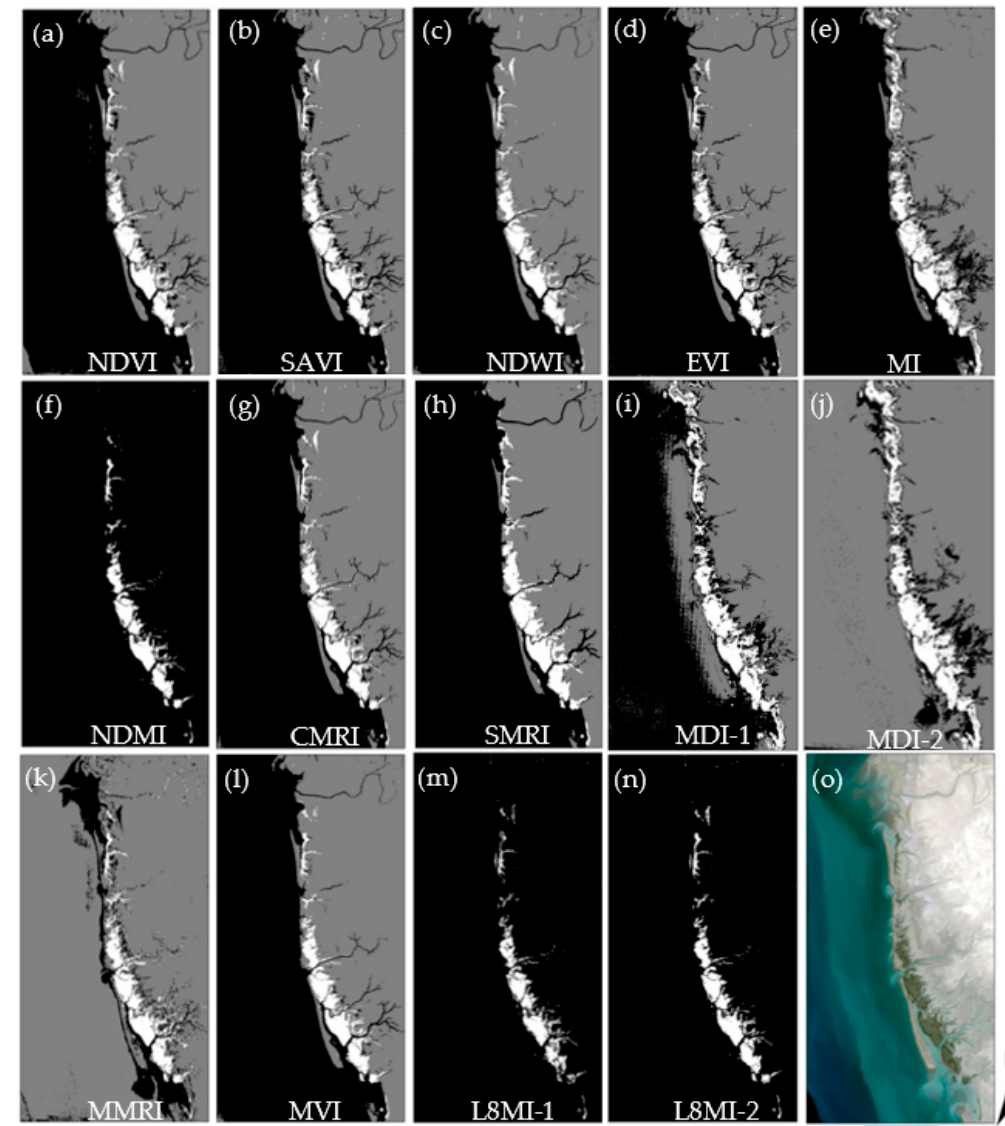
Figure 3. Results of the vegetation indices (i.e., NDVI, SAVI, NDWI, and EVI, shown in panels ( a – d )) and mangrove-specific indices (i.e., MI, NDMI, CMRI, SMRI, MDI, MMRI, MVI, and L8MI, shown in panels ( e – n )) from the low-tide and multi-tidal Landsat 8 image in S6 (Hara Roud-e Gaz protected area in Figure 1). ( o ) is the low-tide Landsat 8 image in S6. (Note: MDI-1 and L8MI were computed by SWIR1 (MDI-1 and L8MI-1, respectively) and SWIR2 (MDI-2 and L8MI-2, respectively) wavelengths. White areas represent mangrove forests).